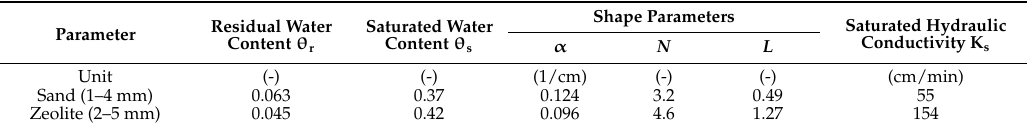
the maximum nitrification rate from 0.9/day to 0.175/day, the simulated effluent concentrations Table 6. Estimated soil hydraulic parameters of the van Genuchten–Mualem model [35]. of ammonia nitrogen matched measured data well (“Effluent (Sand)—Simulated 2” in Table 7). Parameter